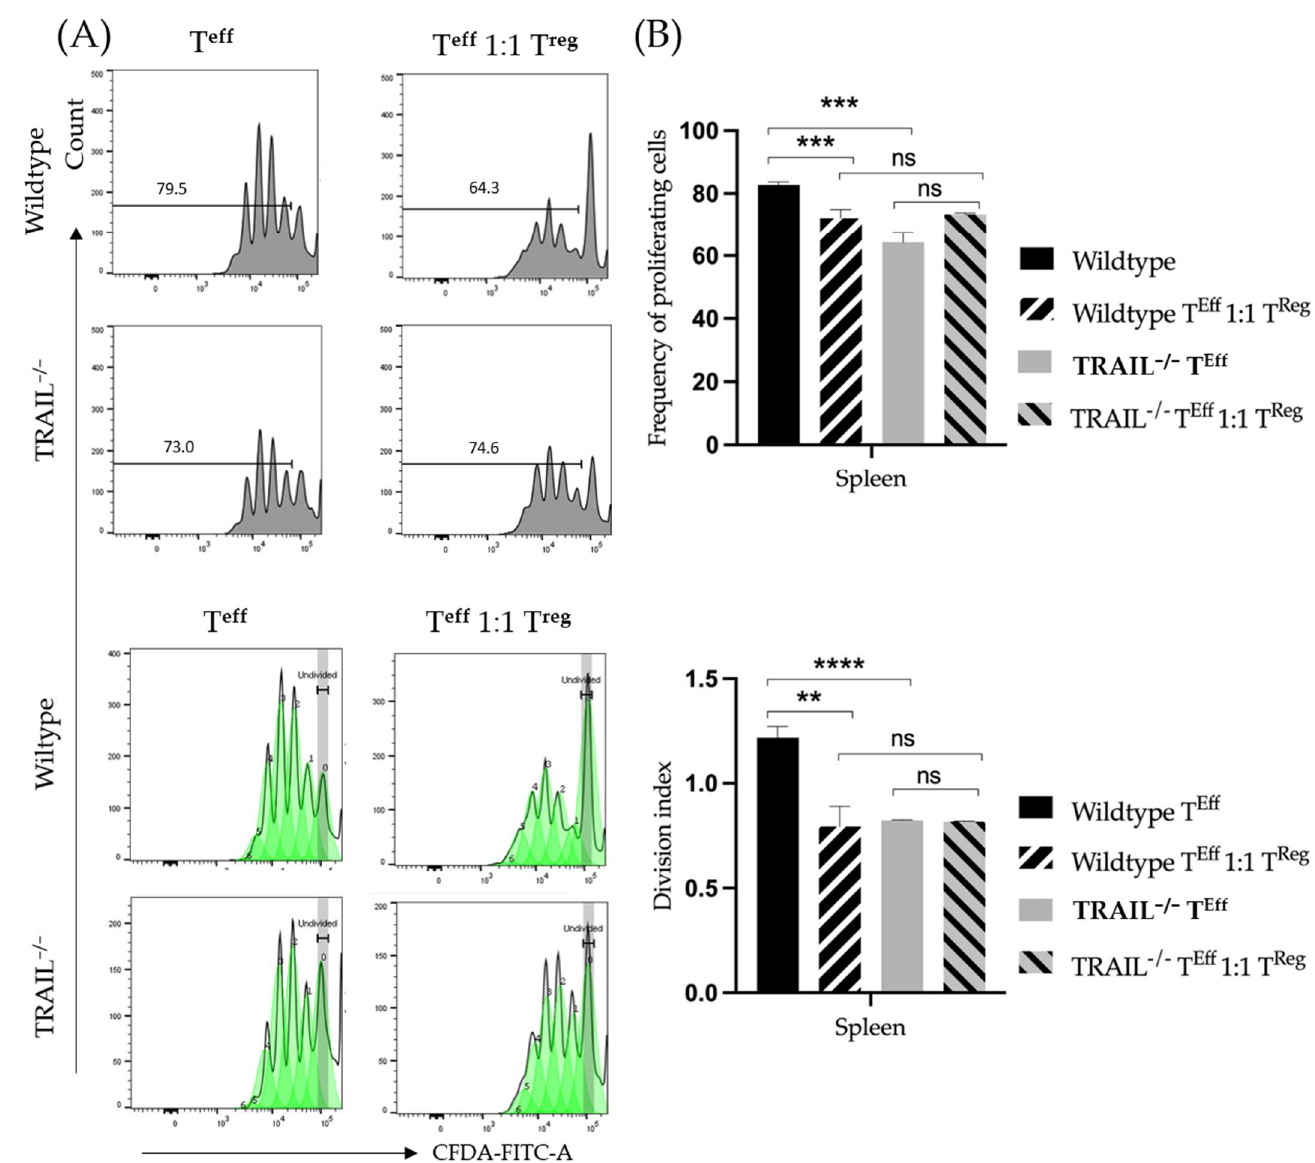
Figure 12. ( A ) CD4 + CD25 + T-cell proliferation alone versus proliferation in the presence of CD4 + CD25 + regulatory T-cells from TRAIL −/− mice versus wildtype C57BL/6 mice. ( B ) Histogram compares the TRAIL effect on the suppressive capacity of the regulatory T-cells of TRAIL −/− mice versus wildtype C57BL/6 mice. Data were obtained ( n = 4–6 per group, one-way ANOVA, Tukey post-test, ** p < 0.01, *** p < 0.001, **** p < 0.0001). Graphs show mean ± SD.